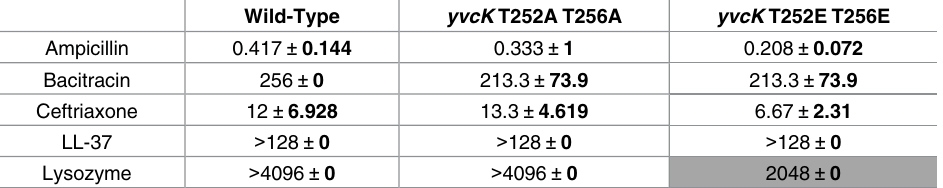
Table 2. Minimum inhibitory concentrations of cell wall targeting agents in BHI. Values are mean min- imum inhibitoryconcentrations and standard deviationsin μ g/mL. Values were determinedby three or more biologicalreplicates of serial 2-fold dilutions up or down from 1 μ g/mL. Shaded boxes are statistically signifi- cant compared to wild-type (Student’s T-Test P <